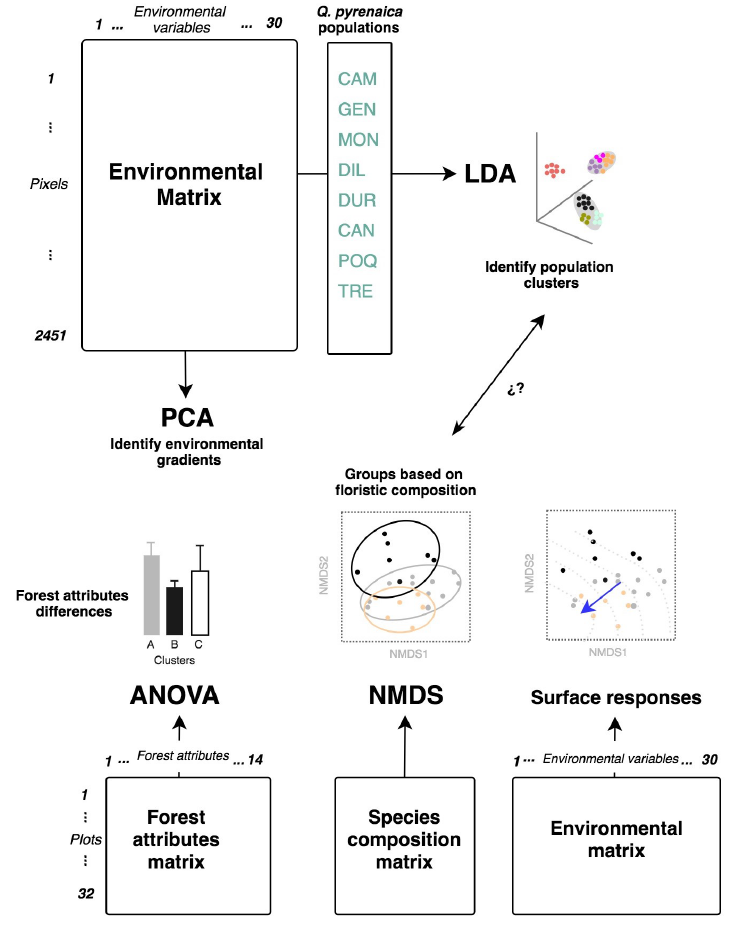
Figure 2. Methodological scheme of the analyses. Using an environmental data matrix, the main environmental gradients that characterize the oak forests at Sierra Nevada were identified using a Principal Component Analysis (PCA). Linear Discriminant Analysis (LDA) was also applied to identify different groups of oak populations. With a matrix of floristic composition, a Non- metric Multidimensional Scaling (NMDS) ordination were applied to visualize patterns of species composition, interpret them according to the environmental factors, and identify groups of oak populations based on similarities between floristic composition. See Materials and Methods for more